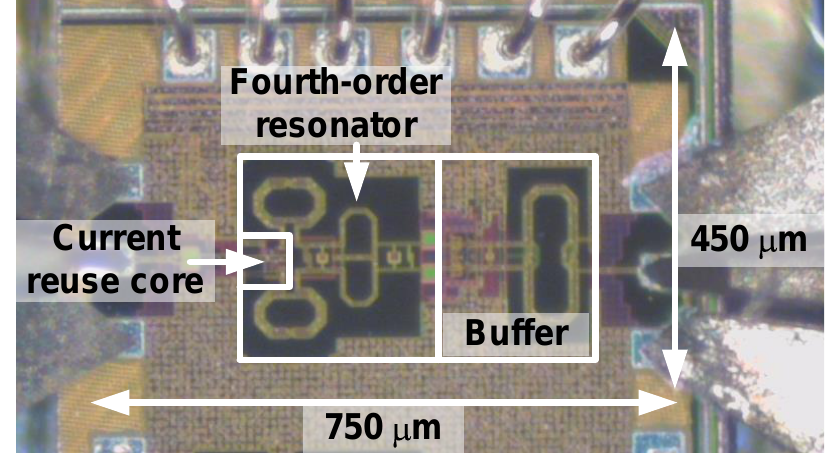
Figure 10. Die photograph of the proposed CR-ILFD.